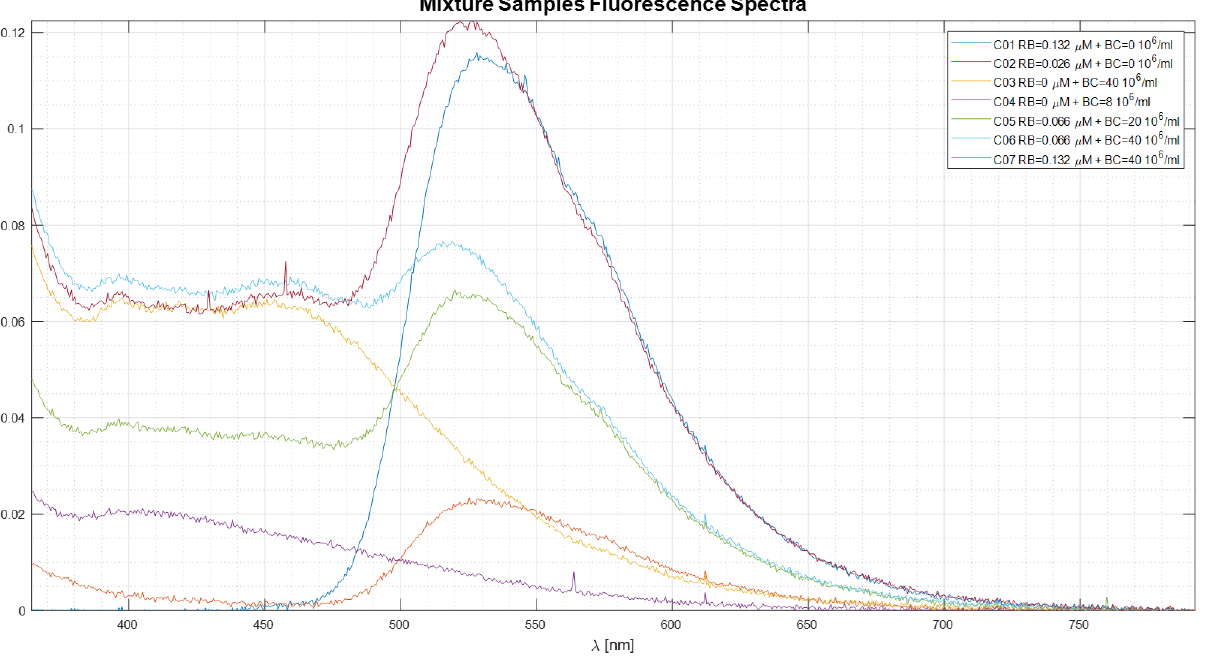
Figure 8. The plot shows the average fluorescence spectra of the mixture